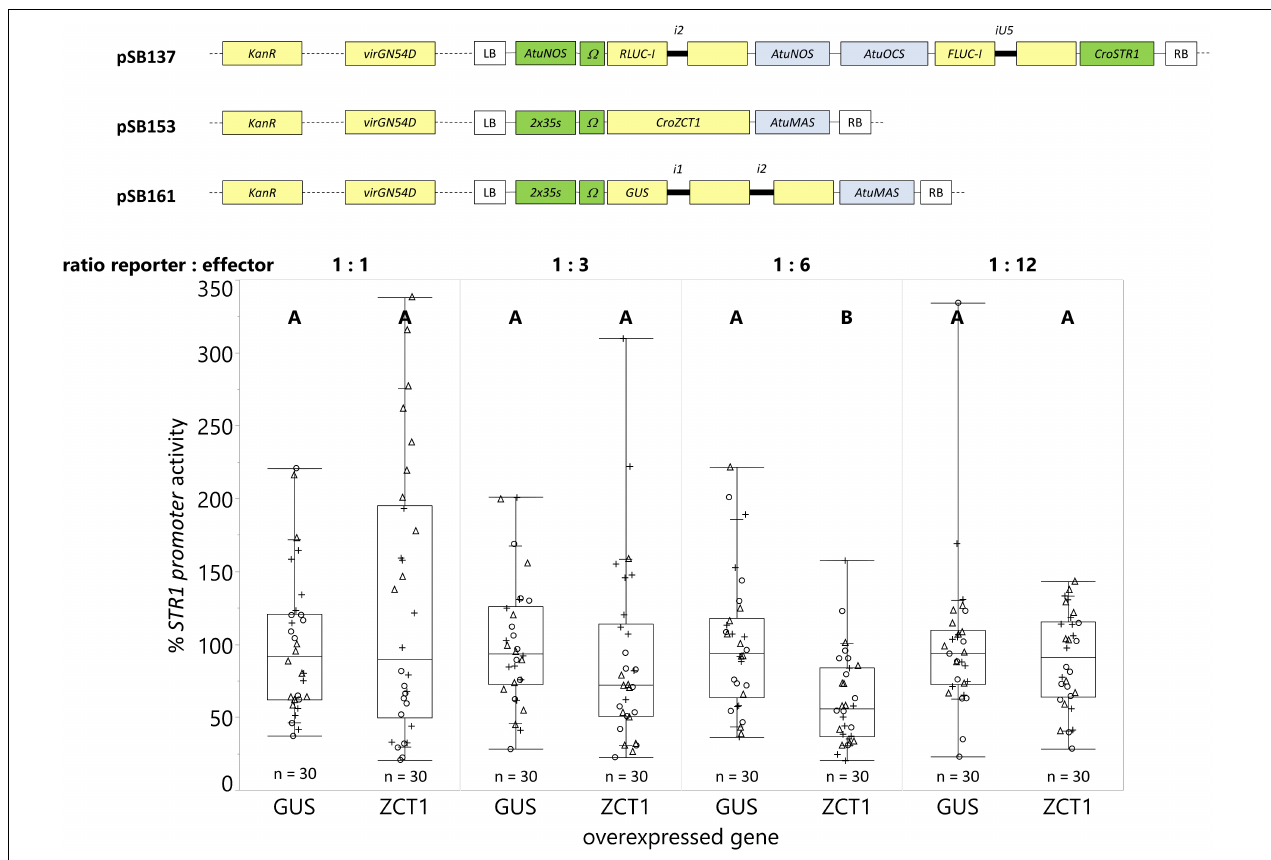
FIGURE 9 | A ratio of 1-part reporter strain and 6-parts effector strain provides the highest sensitivity in transactivation assays. C. roseus seedlings (10-days-old) were vacuum infiltrated with a combination of two strains of A. tumefaciens (total OD 600 = 0.4): (I) strain containing the CroSTR1 promoter driven FLUC-I reporter and the AtuNOS promoter driven RLUC-I normalization reporter (plasmid pSB137), and (II) strain containing a CaMV2x35s driven effector for transactivation (GUS as control – pSB161 or ZCT1 – pSB153). Samples were taken 3 dpi. For each reporter to effector ratio, the CroSTR1 promoter activity is the FLUC to RLUC activity ratio for each sample normalized to the FLUC to RLUC activity ratio of the GUS control (set to 100%). The experiment was carried out in three independent assays (represented by the + , (cid:13) , (cid:49) symbols). The box plot horizontal line shows the median, ends of the boxes show interquartile range, small marks show the 10th and 90th quantile, and whiskers show lowest/highest data point. Different letters indicate significantly different values. ZCT1 overexpression significantly decreased the expression of the STR1 promoter in the 1:6 ratio, but not in the other ratios (Student’s t -test comparing each condition to its GUS control on log-transformed data, p <